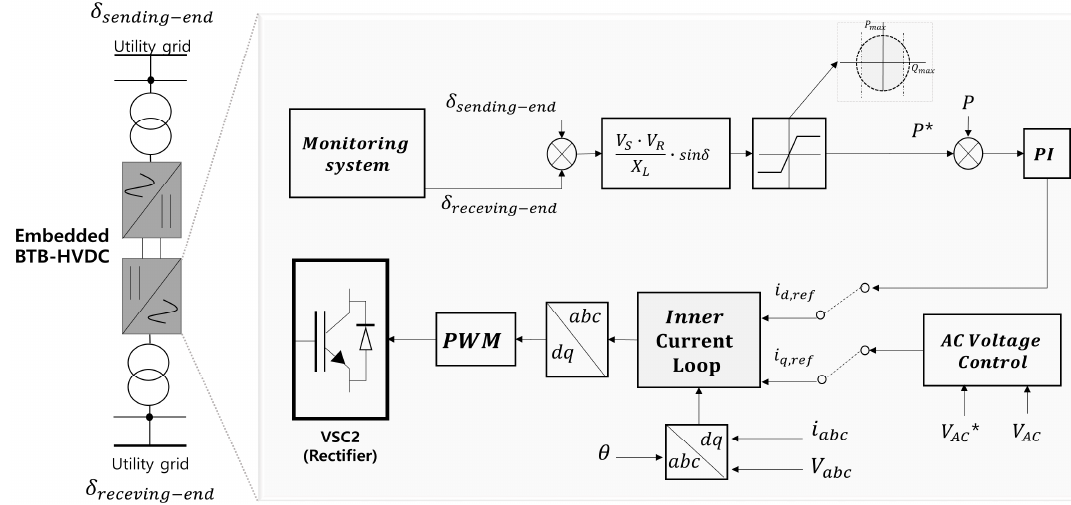
Figure 3. The first AC transmission emulation control (ATEC) strategy structure with monitoring system.